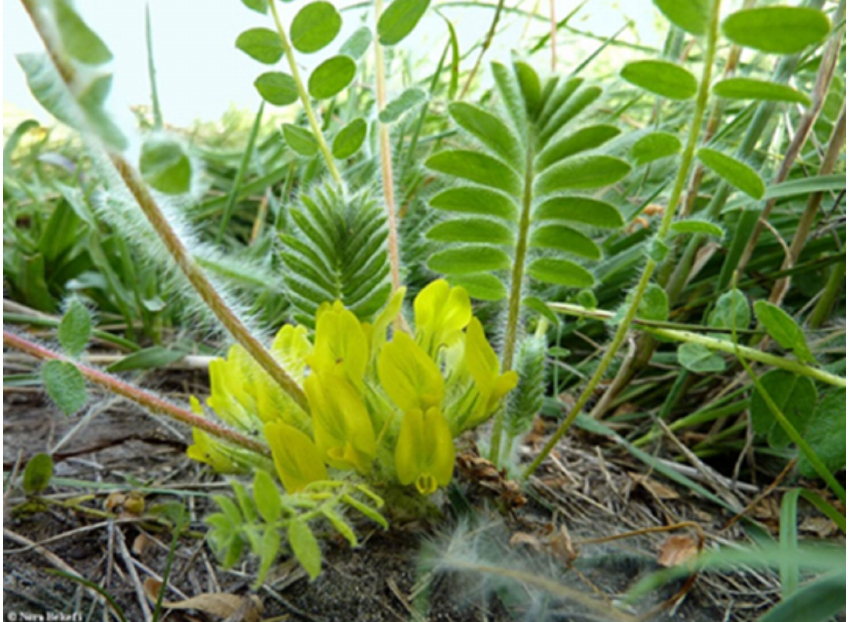
Figure 1. Original image of Astragalus exscapus L. subsp. transsilvanicus (Schur) Ny á r. plant from the G ă d ă lin population, Cluj County,